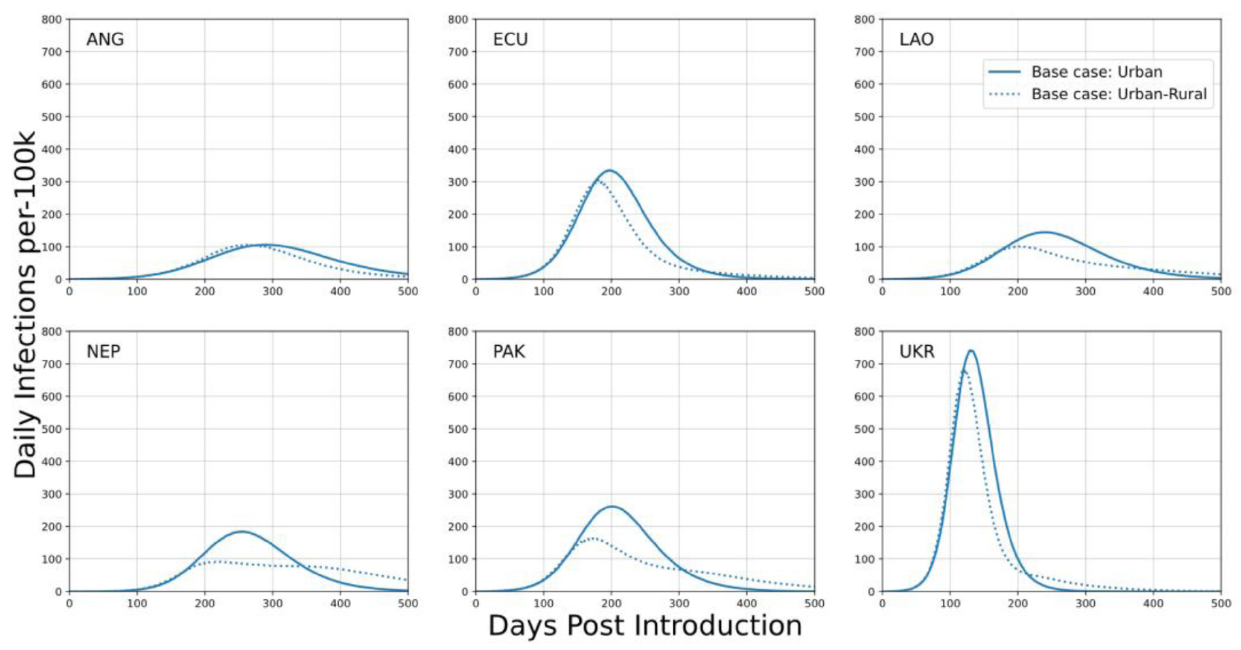
Figure 1. Daily infection trajectories per 100k population for the ‘urban’ base case and for the ‘urban-rural’ base case. In the ‘urban-rural’ base case, the urban fraction of the population is in the largest population center and the remainder of the population is distributed across smaller population centers. The x-axis describes the number of days post SARS-CoV-2 introduction to the community. Baseline scenarios for each country assume school closures, reduced work contacts, and restricted community gatherings.